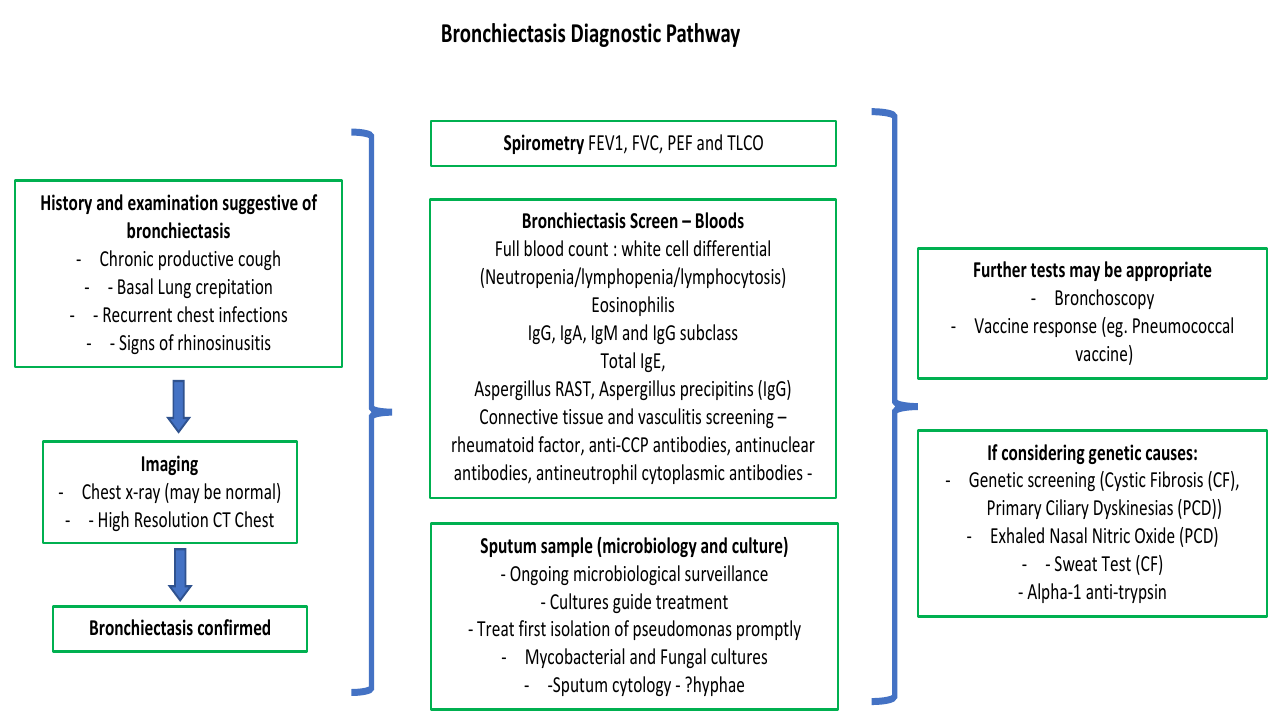
Figure 1. Bronchiectasis diagnostic flowchart.